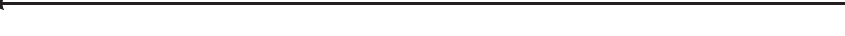
Figure 3: Demonstrations of modulators based on different operation mechanisms. (A) Schematic illustration of the quantum cascade laser-integrated graphene modulator. Only the central few rings of the CCG (orange region) are connected together with the spoke bridges to allow electrical pumping of the quantum cascade laser (QCL) over a small active region. Light is emitted vertically from the surface and is modulated by the electrically gated graphene. (B) V dependence of the output G power of the CCG QCL with (circles) the graphene. The pumping current of the QCL is 2.80 A (A and B reproduced from [94] with permission from ACS Photonics). (C) Optical micrograph of the Mach-Zehnder interferometer (MZI) modulator. The top arm has a 400 μ m single-layer graphene on Si, the bottom arm has a 300 μ m single-layer graphene on Si. (D) Cross-section of the graphene phase modulator through the dashed line A-A ′ of (C) (C and D reproduced from [95] with permission from Nature Photon). (E) Schematic of the cavity-graphene electro-optic modulator. The dual-layer graphene capacitor on the quartz substrate is optically coupled to the planar photonic crystal cavity (E reproduced from [106] with permission from Nano Letters). (F) A three-dimensional schematic drawing of a single-layer graphene electro-absorption modulator (EAM) integrated on the SOI platform. Cross-section of the graphene EAM (F reproduced from [96] with permission from Laser & Photonics Reviews). (G) Schematic of the electro-optic modulator, where a single Au nanodisk with a radius of 60 nm is deposited on the MoS monolayers. The coupling strength between a single Au plasmon and MoS exciton can be effectively 2 2 tuned by the gate voltage (G reproduced from [107] with permission from ACS Nano). (H) Schematic cross-section of a graphene-cladded silicon photonic crystal cavity structure built in a silicon layer with a thickness of 220 nm and a lattice constant of 420 nm (H reproduced from [101] with permission from ACS Photonics). (I) A thermo-optic microring modulator based on graphene. Three-dimensional illustration of a thermo-optic microring modulator based on graphene; monolayer graphene is on top of a ring resonator without any separation layer (I reproduced from [102] with permission from Nanoscale). (J) Schematic of the sample and of the experimental arrangement. An array of split-ring resonators (SRRs) is patterned on the surface of a gallium arsenide substrate. A graphene monolayer is transferred on the surface and isolated by a silicon oxide layer from the SRR (J reproduced from [108] with permission from Applied Physics